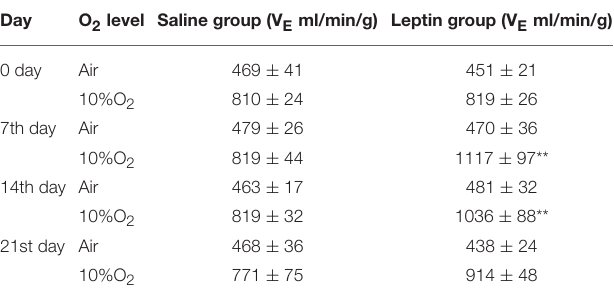
TABLE 3 | V E measured during exposure to room air and